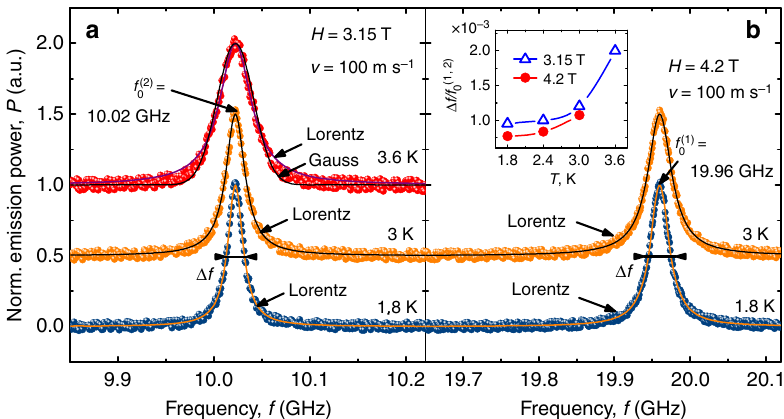
¼ 10 : 02 GHz at H = 3.15 T ( a ) and f ð 1 Þ ¼ 19 : 96 GHz at 0 0 0